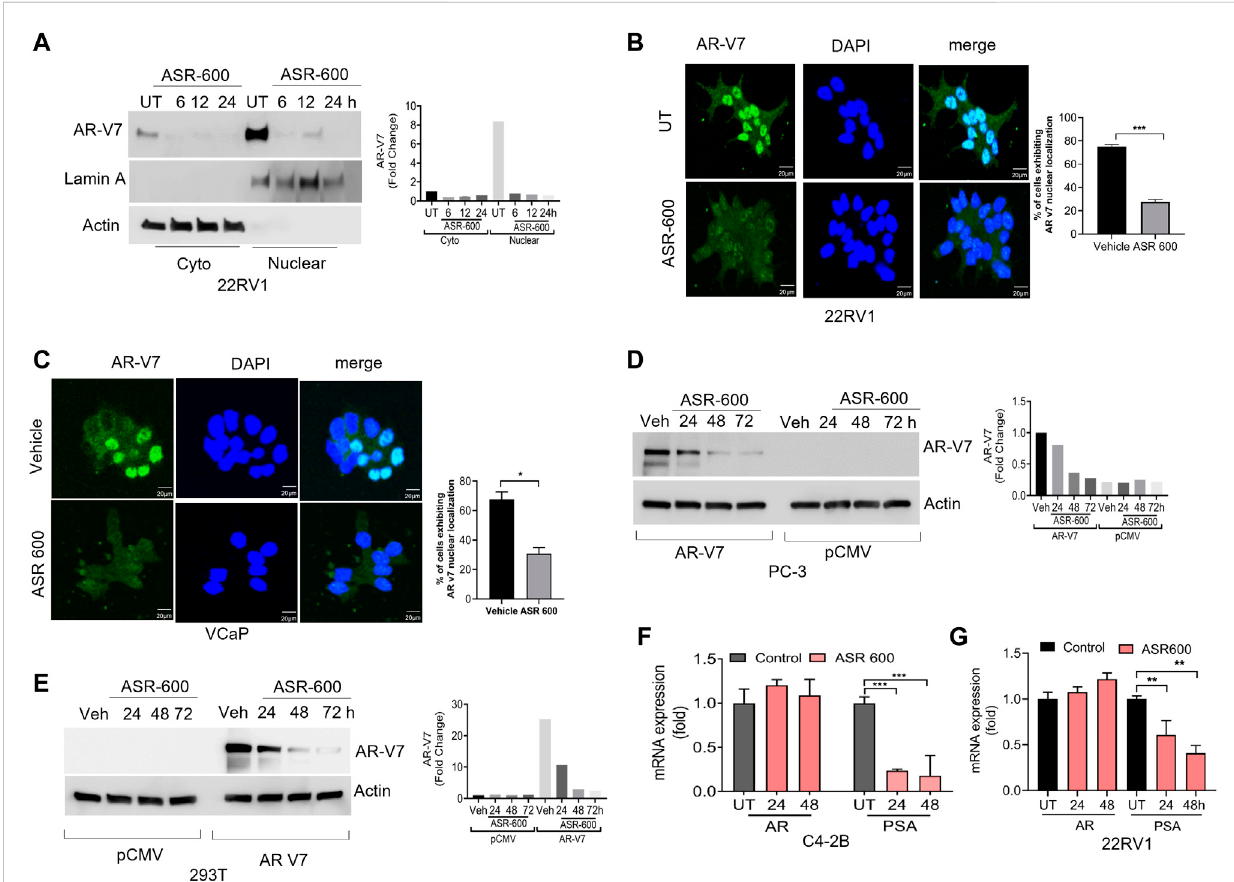
FIGURE 4 ASR-600 inhibited AR-V7 expression in CaP cells. (A) Immunoblots demonstrating subcellular fractionation in 22RV1 cells treated with ASR-600 for 6, 12, and 24 h. Lamin A and ß-actin were used as the internal controls. (B, C) Immuno fl uorescence analysis of cyto-nuclear localization of AR-V7 expression in ASR-600 treated 22Rv1 and VCaP cells. (D, E) Immunoblots for AR-V7 expression in PC-3 or 293T cells transfected with AR V7 or empty vector and treated with ASR-600 for 24, 48 and 72 h. (F, G) AR and PSA mRNA expression of ASR-600 treated C4-2B and 22Rv1